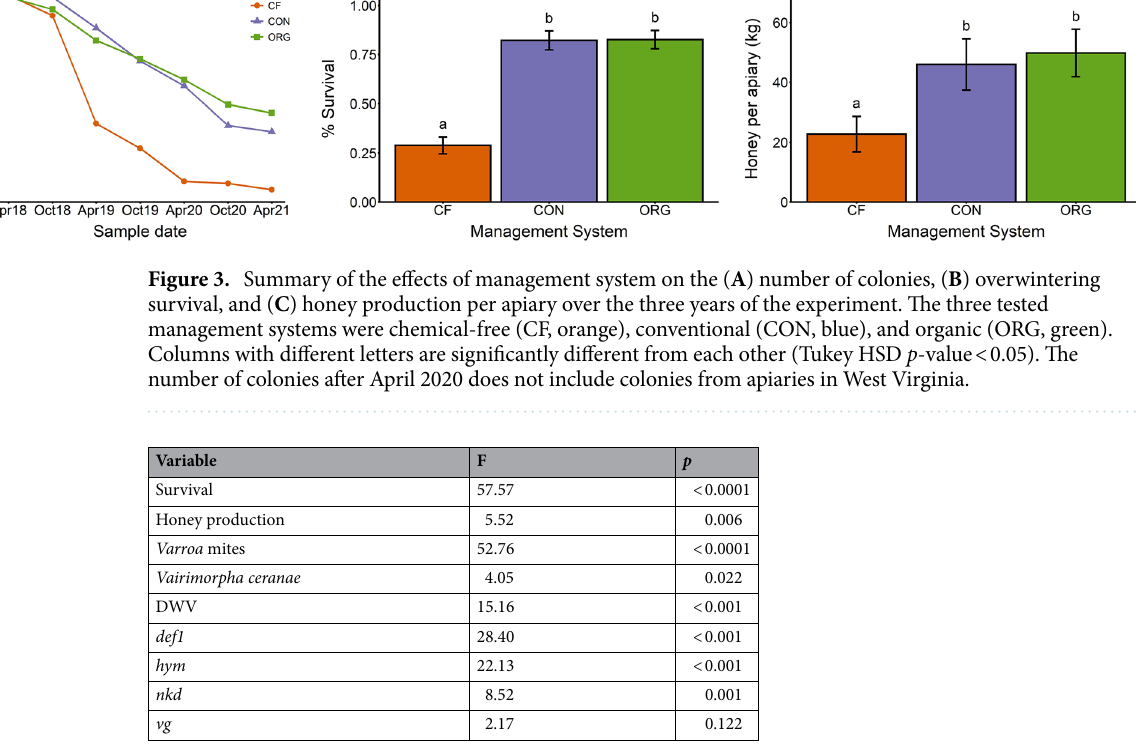
Table 2. Results of mixed linear models showing effects of the management systems on the different response variables (survival, honey production, pests, pathogens, and gene expression) averaged across 3 years. Farms were used as random effects. Degrees of freedom for all tests are ndf = 2 and ddf =